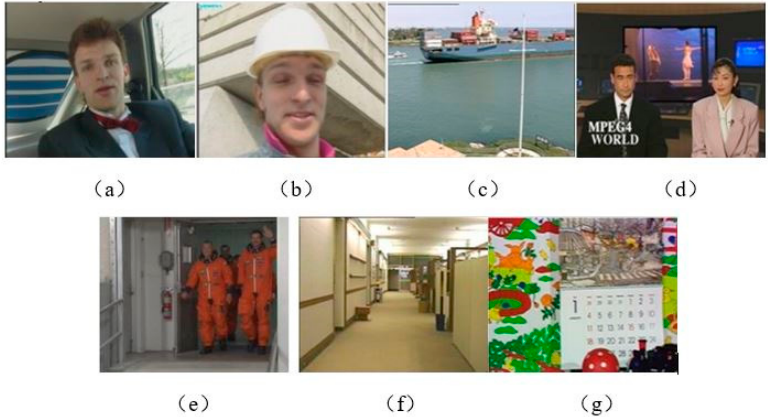
Figure 5. Original video frame: ( a ) Carphone, ( b ) Foreman, ( c ) Container, ( d ) News, ( e ) Crew, ( f ) Hall, and ( g ) Mobile.